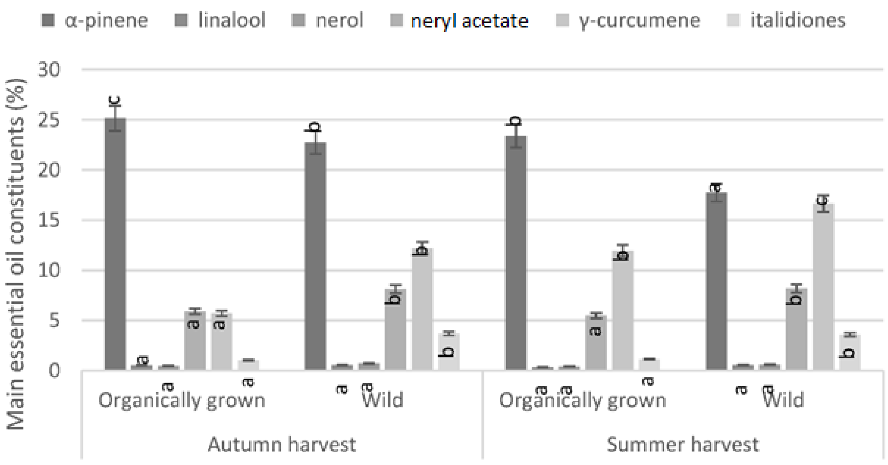
Figure 3. The influence of the analyzed factors on the essential oil constituents. (The bars designated by different small letters (a, b, c) are significantly different ( p < 0.05)). Table 3. Results of the analysis of the variance of the influence of the analyzed factors on the immortelle essential oil constituent at a significance level of p < 0.05.